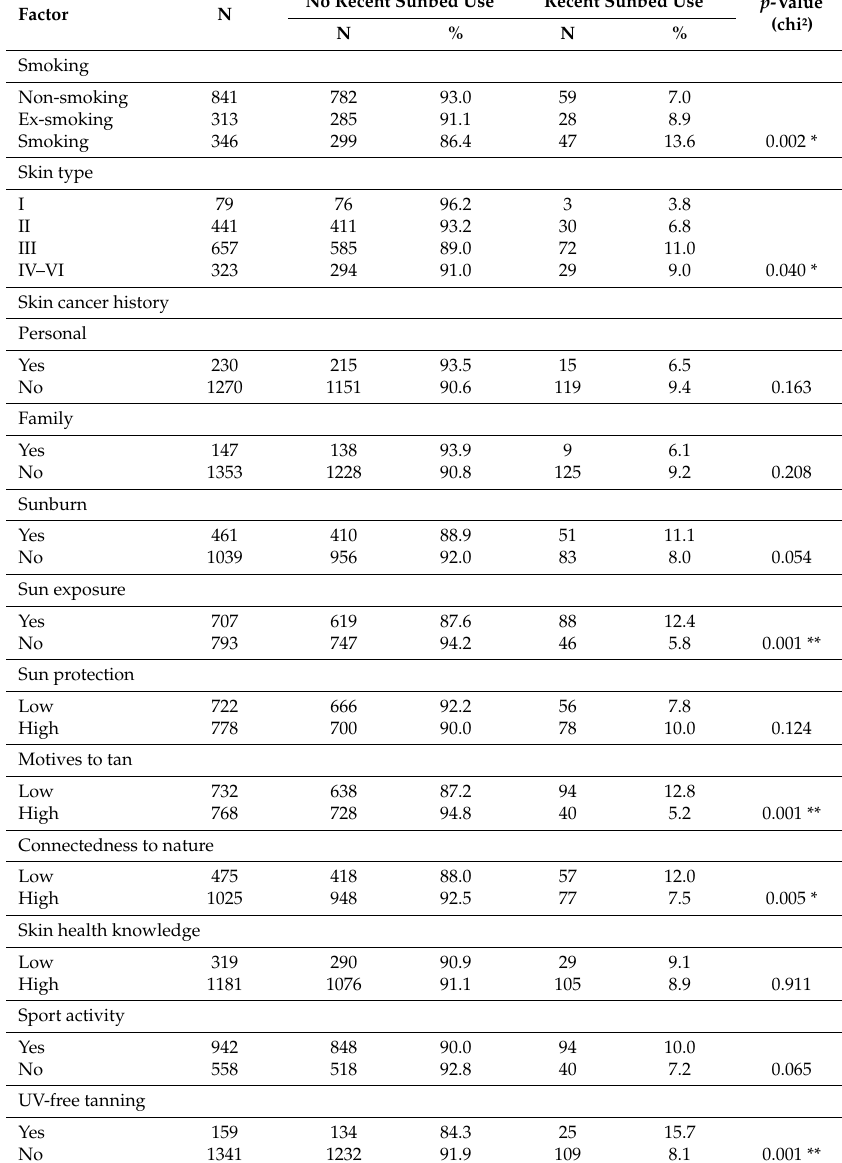
Table 3. Health behavior and skin health characteristics of the study samples, stratified by sunbed use. No Recent Sunbed Use Recent Sunbed Factor N